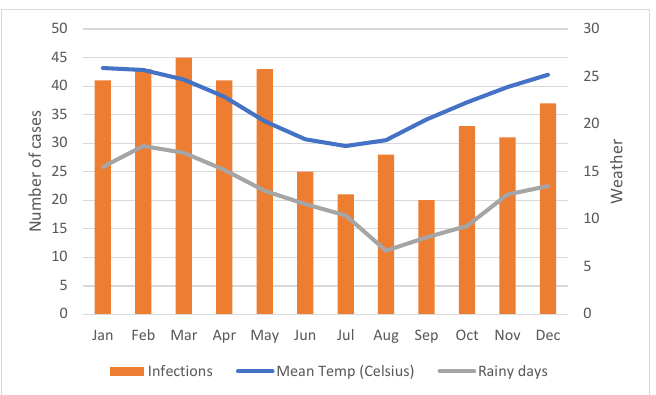
Figure 2. Monthly Aeromonas species bloodstream infections isolated with weather (mean monthly temperature and number of rainy days per month).